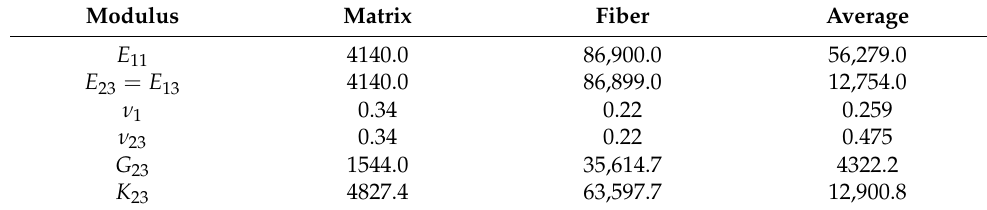
Table 6. Computed values of elastic moduli (Case 3).